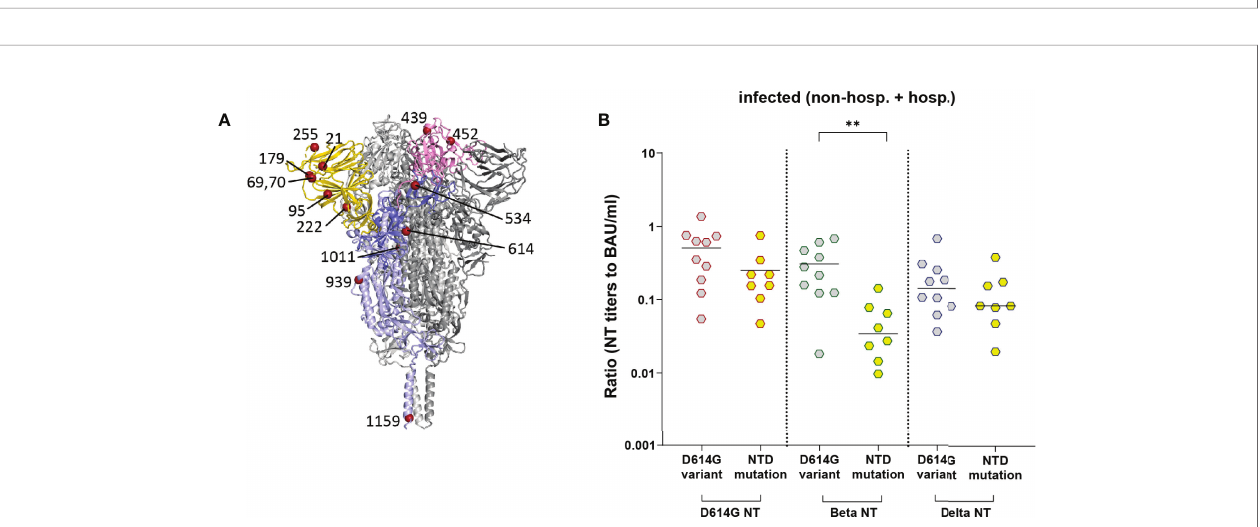
FIGURE 6 | NT/ELISA ratios in infected individuals (non-hospitalized and hospitalized patients) with known S sequence of the infecting strain. (A) Ribbon representation of a G614 S protein (PDB: 7KRQ (23)). Two protomers are shown in grey; one is colored according to S domains (NTD, gold; RBD, pink; S1, medium blue; S2, light blue). The mutations identi fi ed in the infecting strains ( Table 3 ) are shown as dark red spheres. (B) NT/ELISA ratios in early samples of patients infected with the D614G mutation versus D614G plus additional NTD mutations. Early samples were taken approximately three weeks after disease onset. The bars indicate the mean. Statistical analysis was performed with unpaired t-tests. Asterisks indicate statistical signi fi cance: (**) = P ≤ 0.01. non-hosp., non-hospitalized patients; hosp., hospitalized